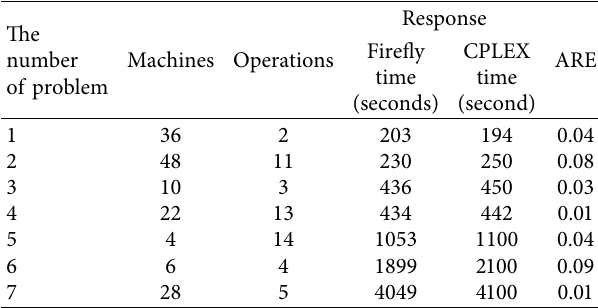
Table 17: Comparing the obtained results from branch and bound